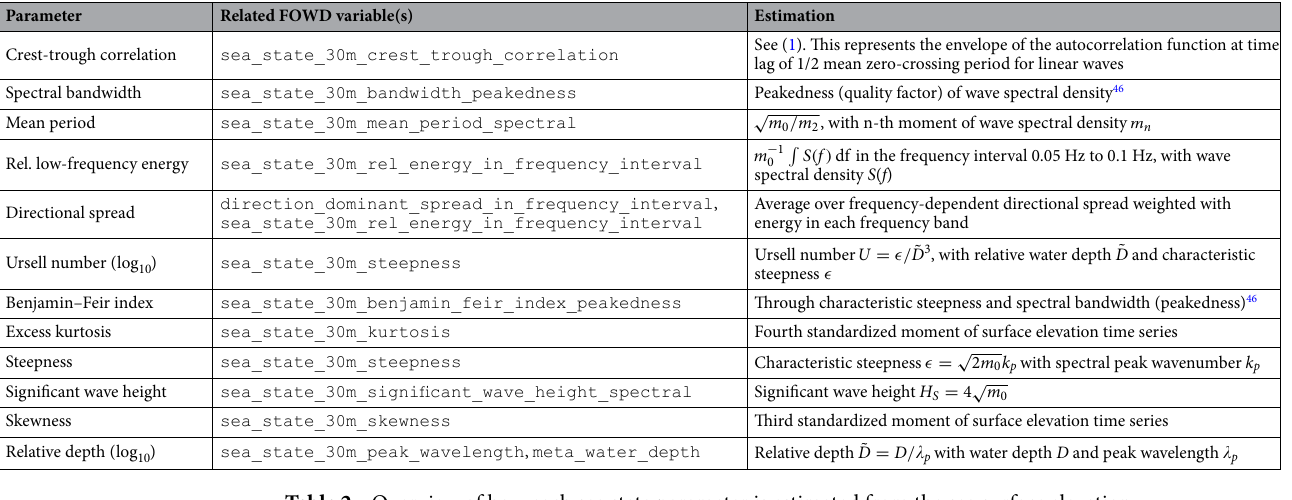
Table 2. Overview of how each sea state parameter is estimated from the sea surface